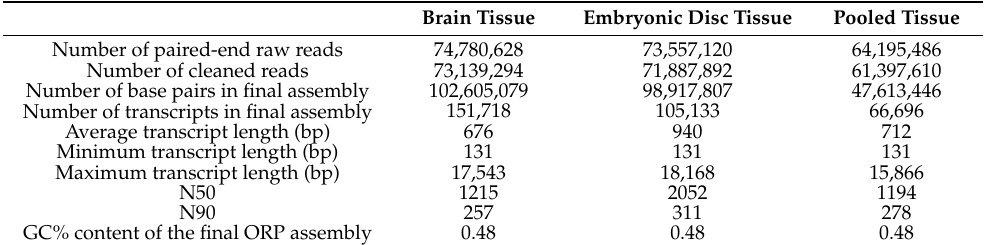
Table 1. Summary of sequencing data used to obtain the de novo transcriptome assemblies of Asymblepharus ladacensis based on paired-end Illumina sequencing. Final assemblies based on four unique assemblies per sample generated by ORP using different assemblers and k-mers. Brain Tissue Embryonic Disc Tissue Pooled